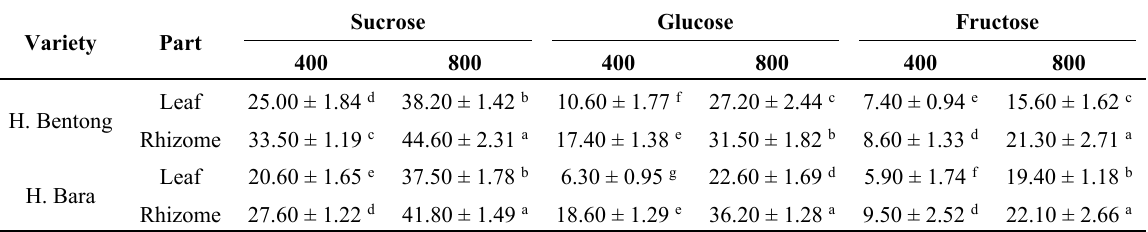
Table 2. Sucrose, glucose and fructose content in two variety of ginger grown under different CO 2 concentration (400 and 800 μ